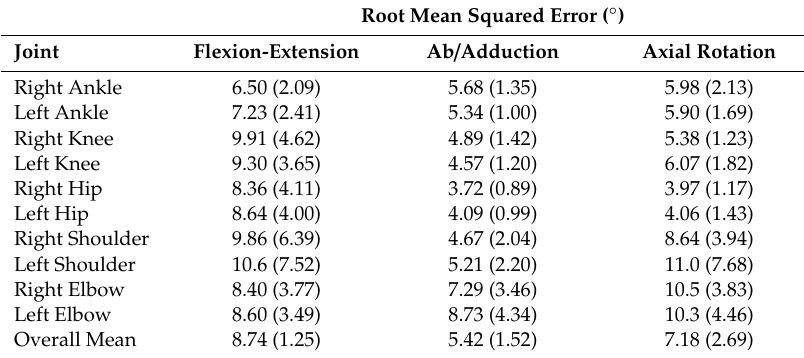
Table 5. Mean RMSE values V OPT vs. V IMU-CAL .